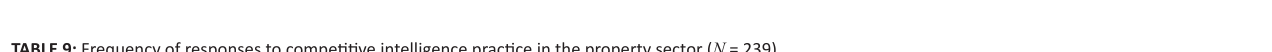
TABLE 9: Frequency of responses to competitive intelligence practice in the property sector ( N = 239).